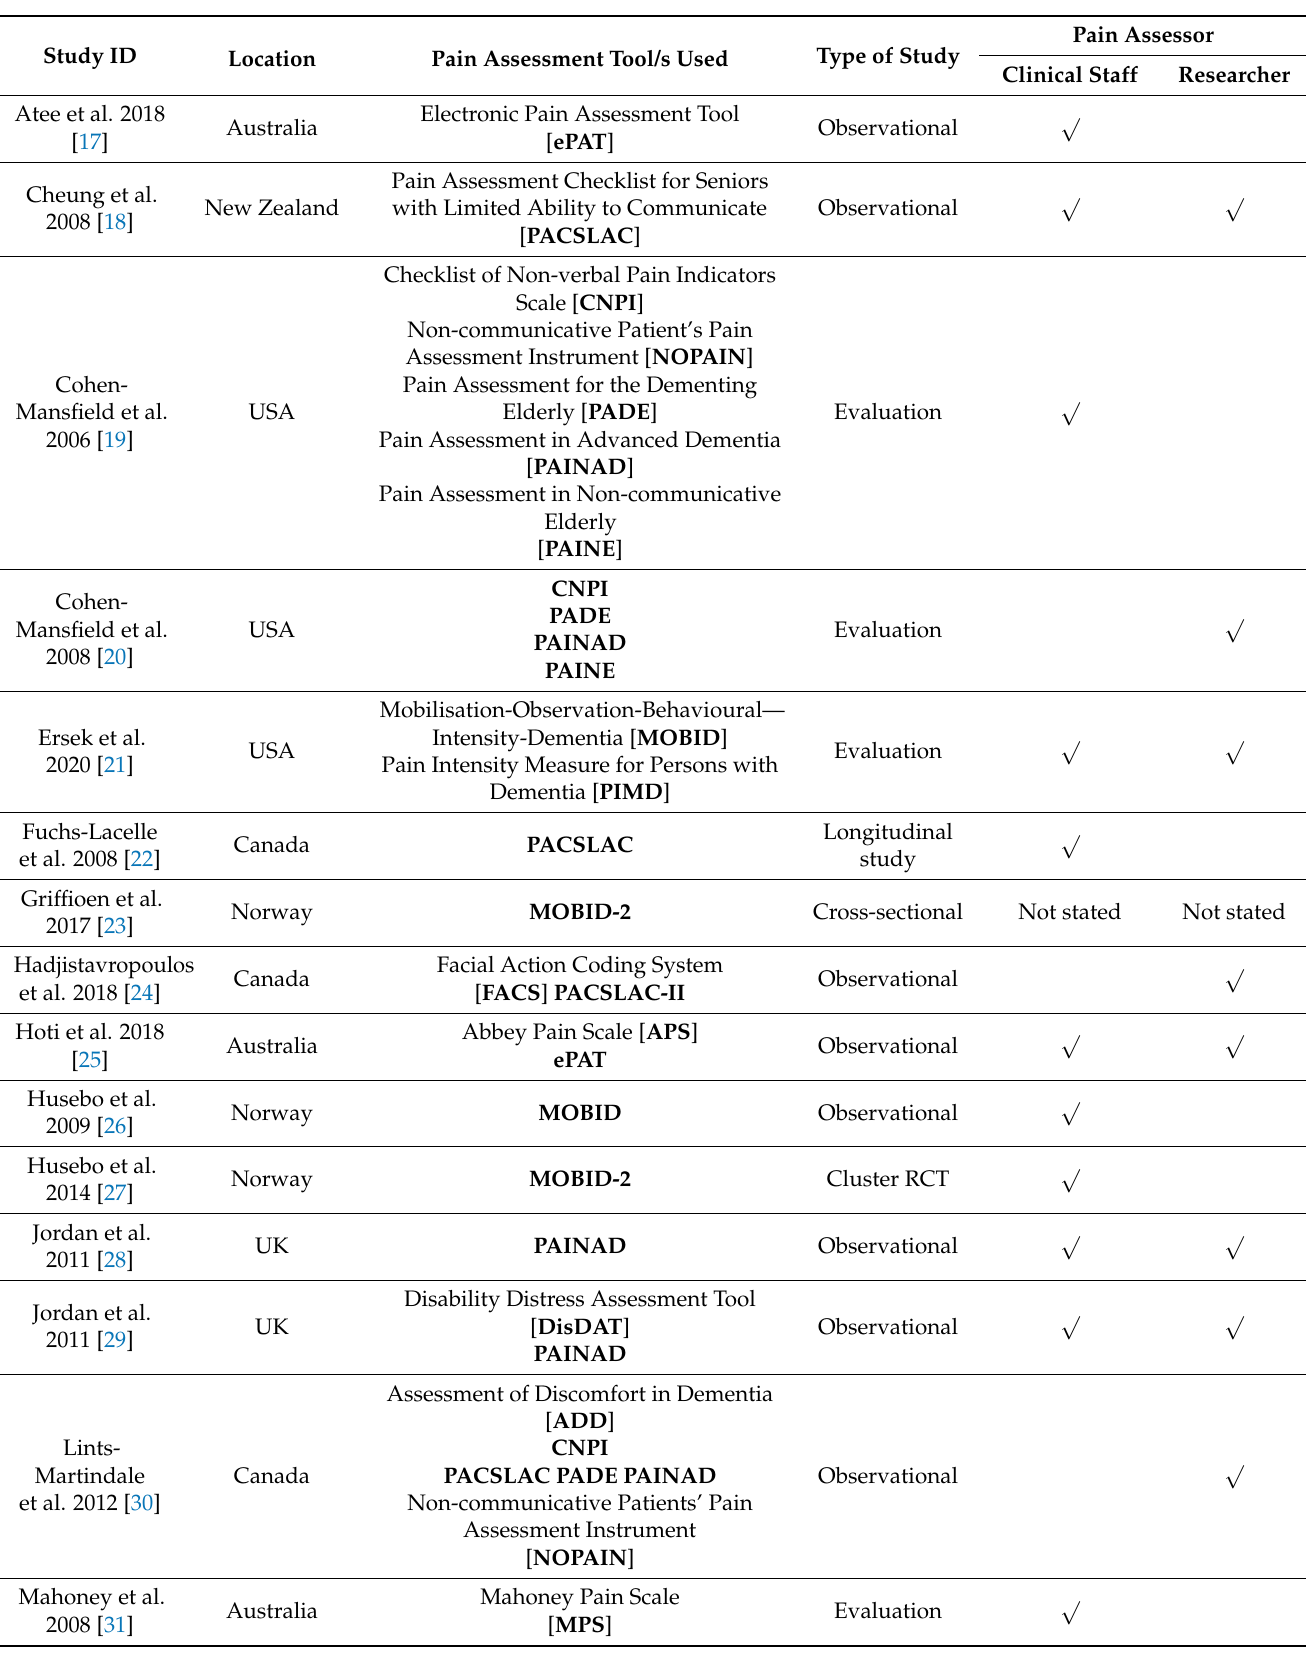
Table 1. Summary of the